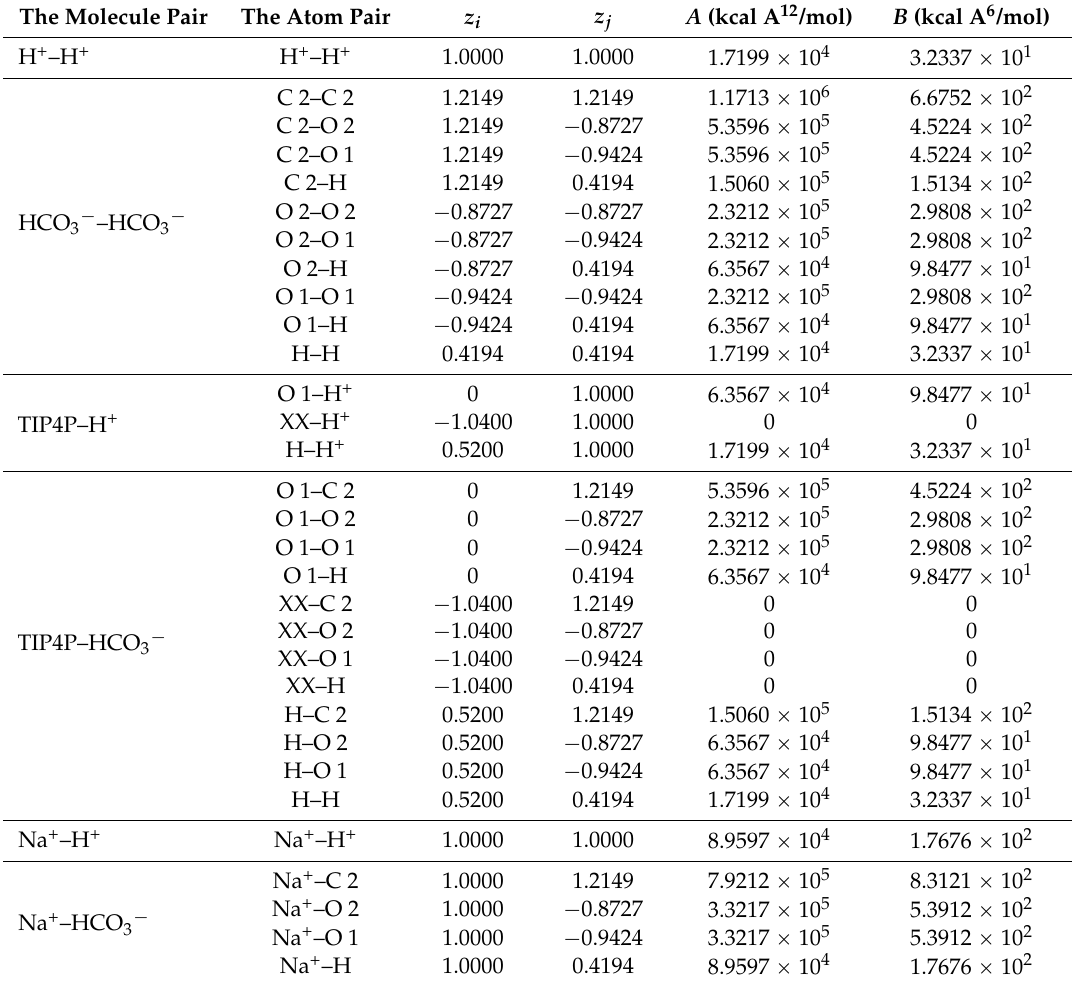
Table 10. The potential parameters between H + –H + , HCO 3 ´ –HCO 3 ´ , TIP4P–H + , TIP4P–HCO 3 ´ , Na + –H + , and Na + –HCO 3 ´ .